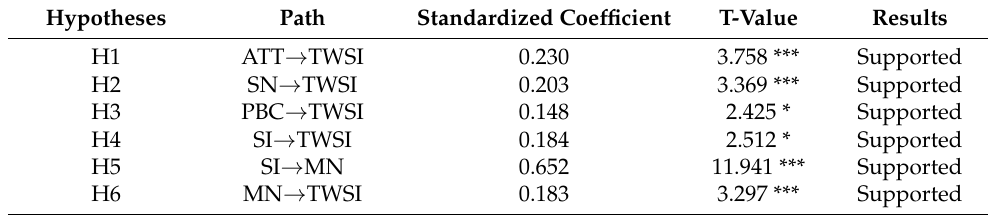
Table 4. Structural model assessment and hypothesis test